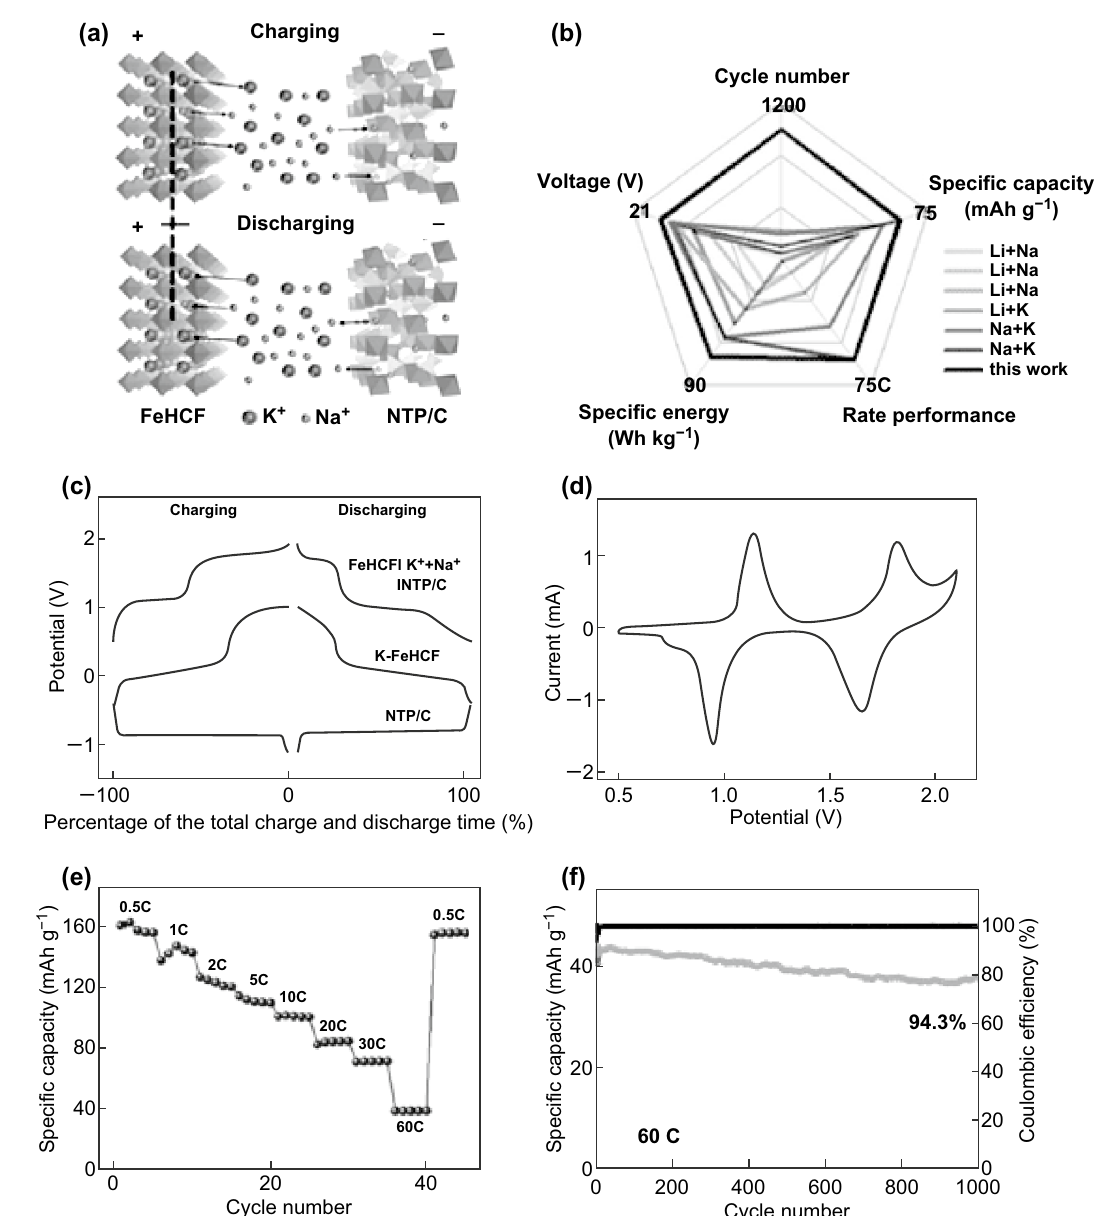
Fig. 11 a Schematic of the K–Na hybrid aqueous battery (HAB). b Performance comparison between the HAB designed in this work and other previously reported mixed-ion aqueous batteries. c Galvanostatic profiles of the HAB along with the voltage profiles of their individual anode and cathode electrodes versus SCE at the rate of 1 C. d CV curves of the HAB at the scan rate of 1 mVs −1 . e Rate performance of the HAB. f Long-term cycling stability of the HAB at the rate of 60 C [186]. Copyright 2018, Wiley-VCH